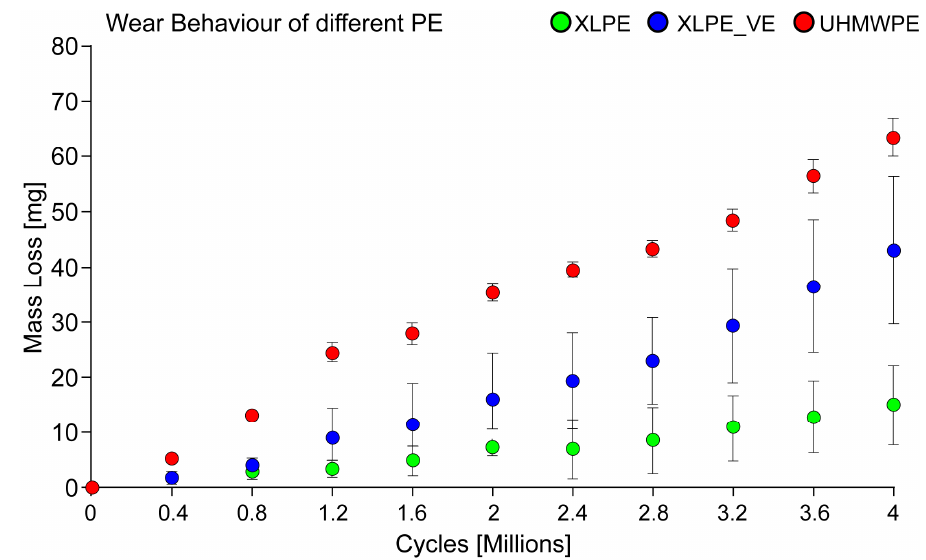
Figure 5. Wear trend of all different configurations of polyethylene (PE). XLPE: cross-linked PE;